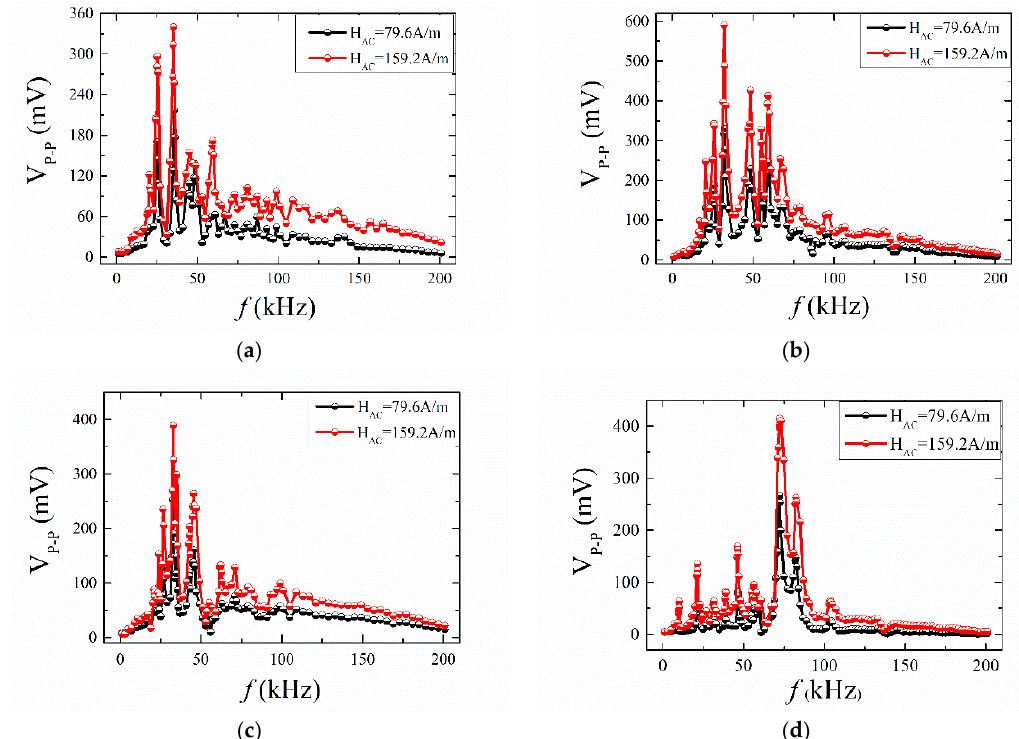
Figure 14. The frequency dependence of the self-biased ME voltage for ME structures at 79.6 A/m and 159.2 A/m; ( a ) ABS- case; ( b ) ABS+ case; ( c ) ABS+- case; ( d ) Mica case.